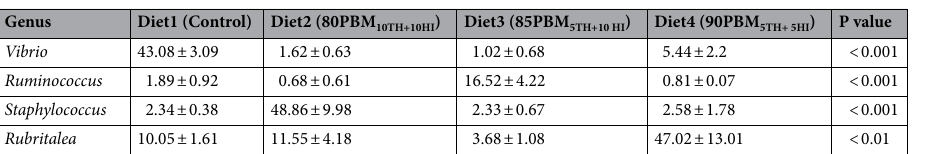
Table 8. Distinguishing bacterial genera in different diets after feeding trial. Each value displayed under the columns diet represents mean relative abundance with standard deviation.